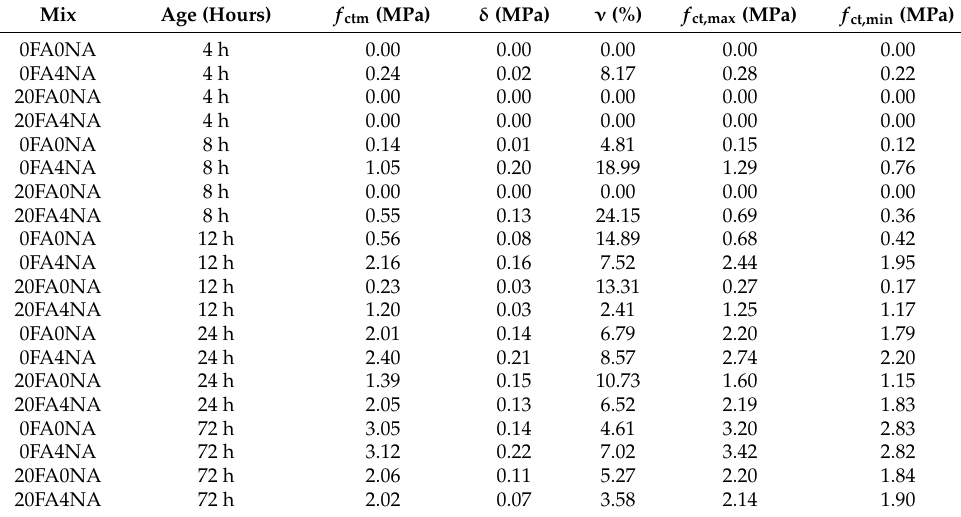
Table 2. Splitting tensile strength f ctm of concretes for each curing